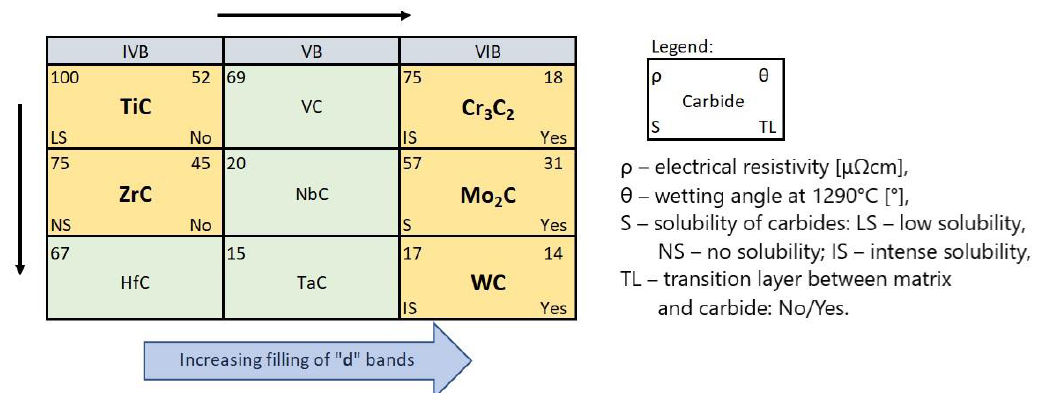
Figure 20. Intensity trends of TMC interactions with the NiBSi matrix during the PTAW formation of SCLs. Each carbide position corresponds to its parent metal location on the periodic table. Carbides subjected to the research are marked.